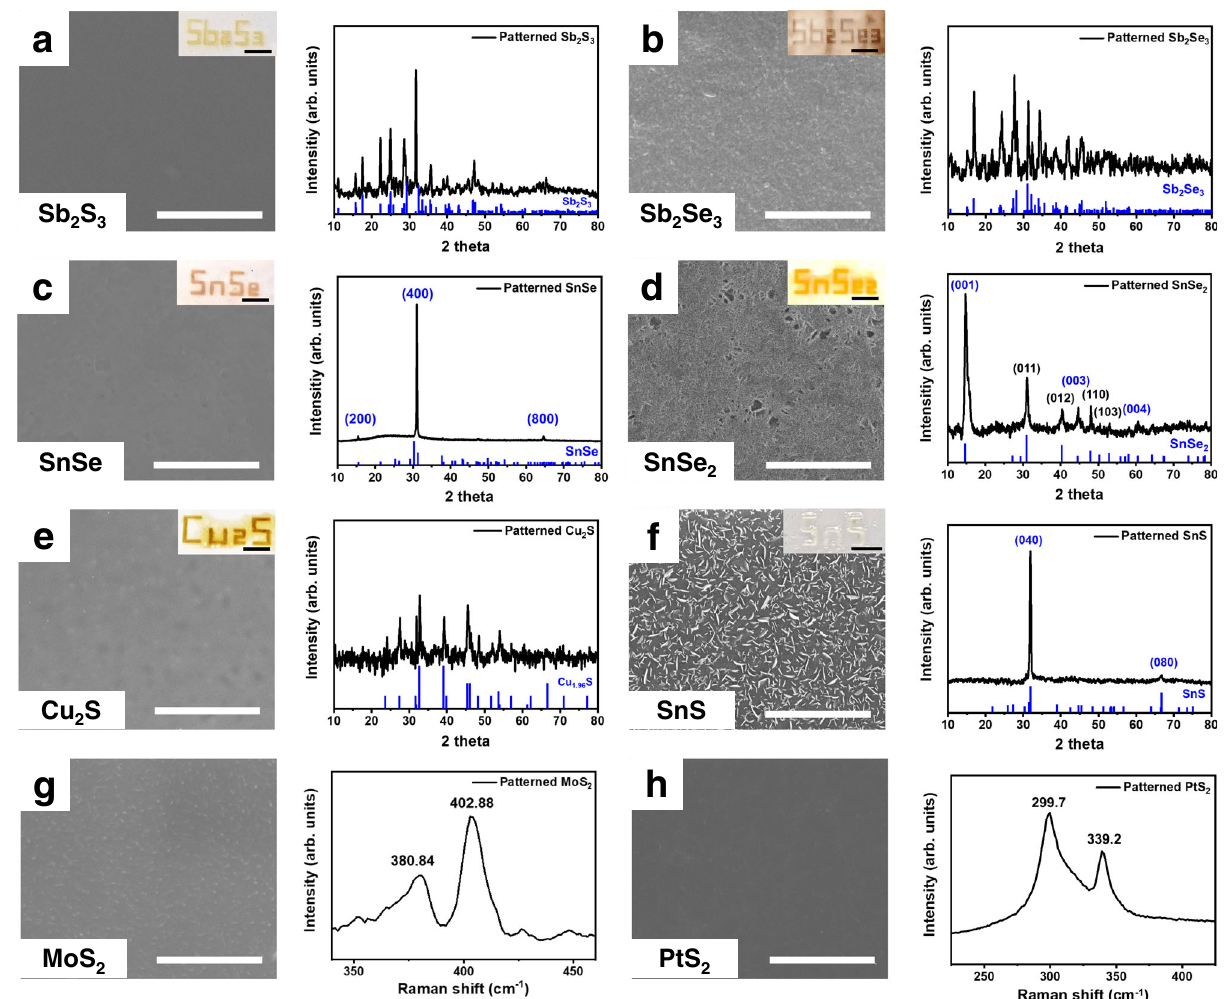
d indicate the peaks other than the a -axis. Vertical blue lines indicate the patterns for the corresponding bulk references (Sb 2 S 3 : JCPDS 03-065-2434, Sb 2 Se 3 : JCPDS 01-083-7430, SnSe: JCPDS 00-032-1382, SnSe 2 : JCPDS 01-089-2939, Cu 1.96 S: JCPDS 00-012-0224, SnS: JCPDS 00-014-0620). SEM images (left) and Raman spectra (right)of g MoS 2 and h PtS 2 .(Scalebars:SEMimages:3 μ m,insetimages:5mm)The labels in panels g and h indicate the Raman shift of the peaks in the